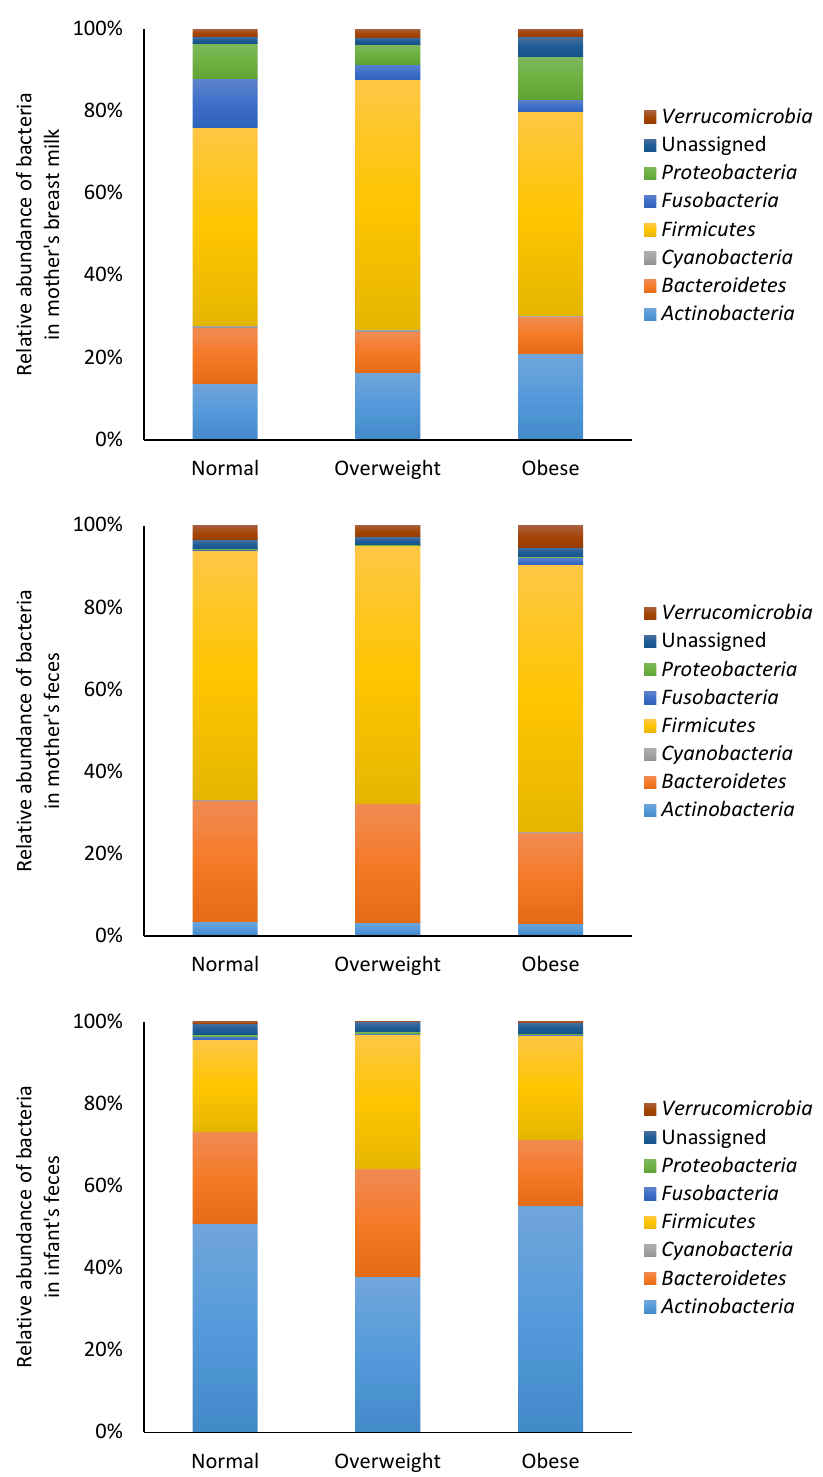
Figure 3. Relative abundance of bacteria at the phylum level in mother and infant. The data were categorized according to the mother’s body mass index.